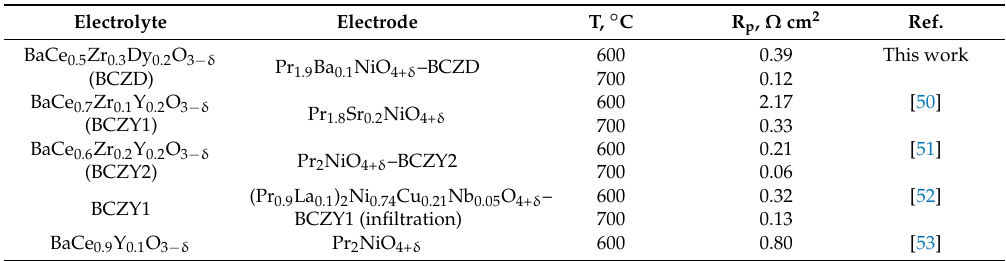
Table 1. Polarization behavior of the Pr 2 NiO 4+ δ -based electrodes of PCCs under OCV mode of operation 1 : T is the temperature, R p is the total polarization of the electrodes.